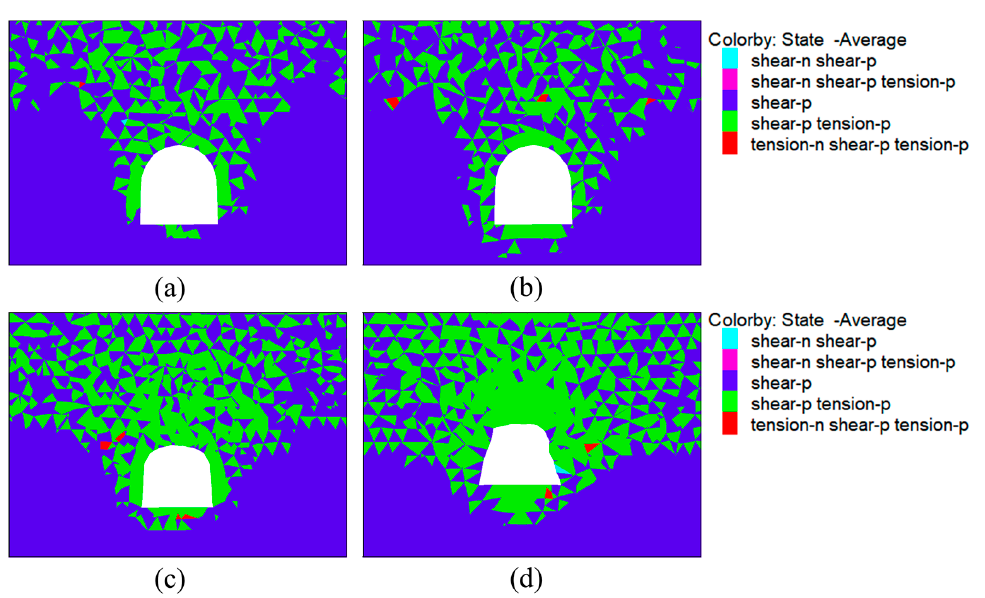
Figure 8. The distribution of the plastic zone in the roadway: ( a ) Case 1; ( b ) Case 2; ( c ) Case 3; ( d ) Case